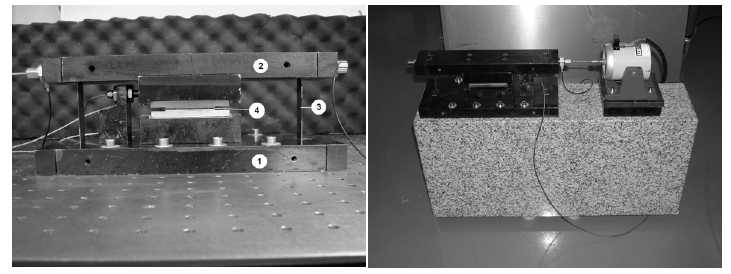
Fig. 2. Viscoelastic characterization